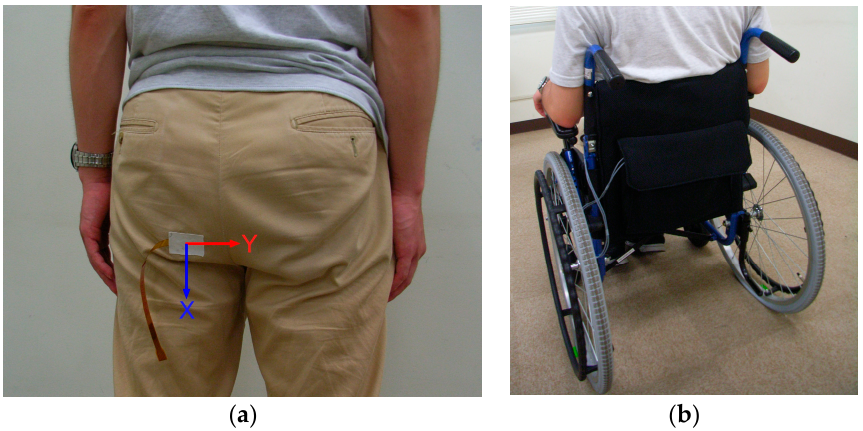
Figure 11. Landscape of a demonstrative measurement using a wheelchair: ( a ) Shear force sensor was attached to the trouser cloth; and ( b ) Experimental subject sat in a wheelchair. The mobile measurement system was housed in the rear pocket.